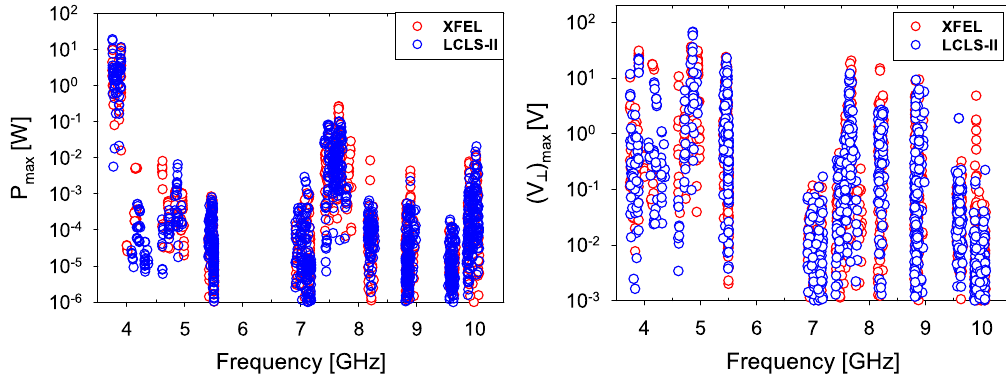
FIG. 10. Resonant HOM losses (left) and transverse kick (right) in 3.9 GHz XFEL and LCLS-II cavities with mechanical